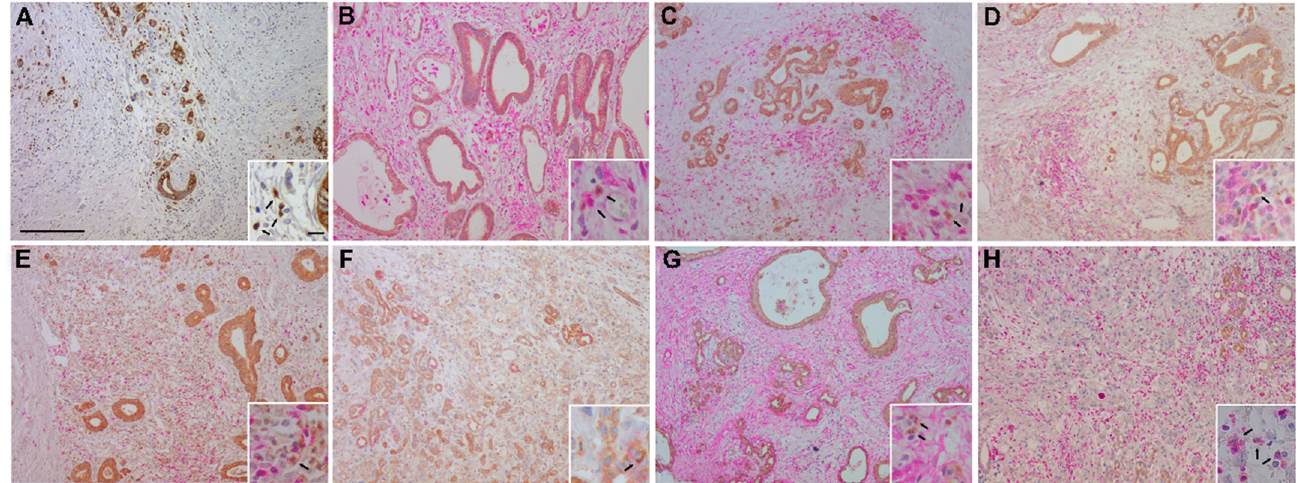
Figure 2. ADAM8 staining ( A ) in PDAC sections and co-localization of ADAM8 (brown) with markers (pink) for CD68 (macrophages, ( B )), CD3 (CD3 + T cells, ( C )), CD4 (CD4 + T cells, ( D )), CD8 (CD8 + T cells, ( E )), CD56 (NK cells, ( F )), SMA (stellate cells, ( G )), and MPO (neutrophils, ( H )). In ( A ), a control stain for ADAM8 alone is shown. Bar in A, 800 μ m; bar in insert ( A ), 100 μ m.